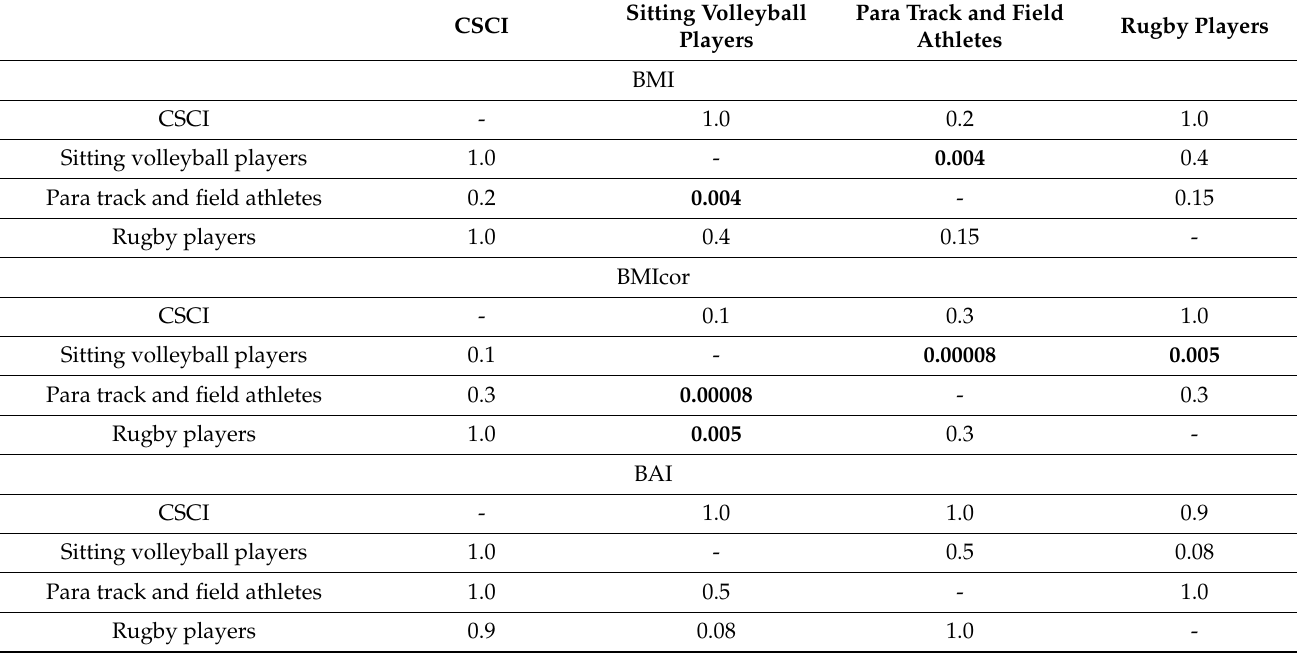
Table 3. Post hoc test for multiple comparisons of indices.